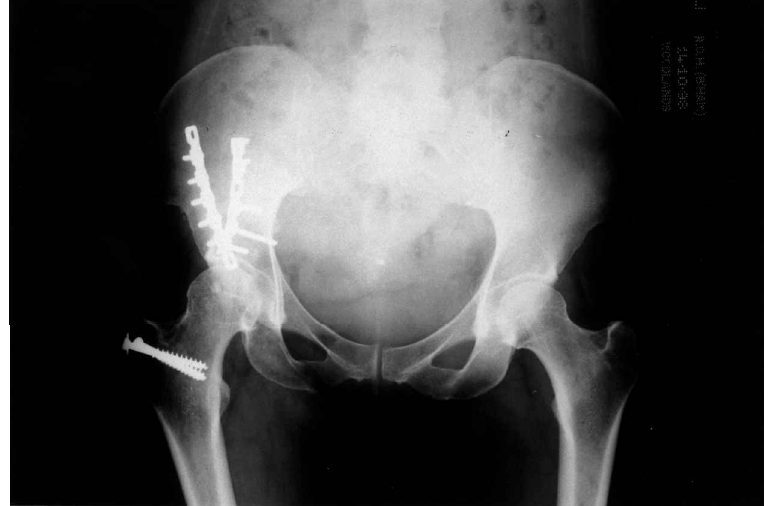
Figure 3. An X-ray taken at 5 years demonstrating complete union of the pelvic and trochanteric